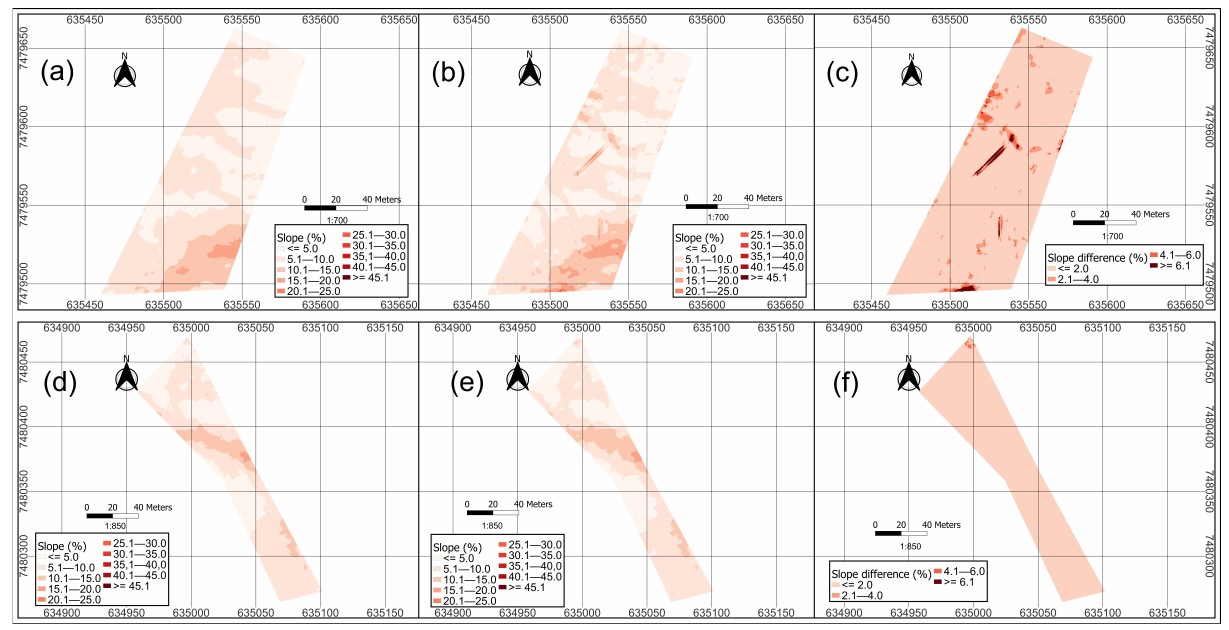
Figure 15. Slope maps for areas 3 and 4 and the differences in slope from both methodologies: ( a ) slope map of area 3, obtained by conventional topographic survey; ( b ) slope map of area 3, obtained using RPA; ( c ) difference in slope between maps ( a , b ). ( d ) slope map of area 4, obtained by conventional topographic survey; ( e ) slope map, of area 4, obtained using RPA; ( f ) difference in slope between maps ( d,e ). Table 2. Occurrence percentages of the slope difference in the total area.